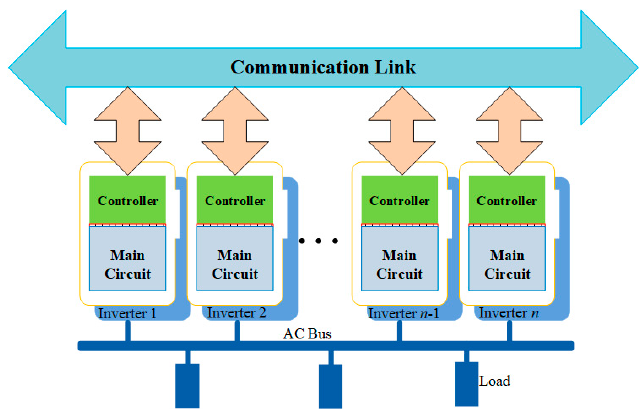
Figure 2. Network-based control system for parallel operation inverters.